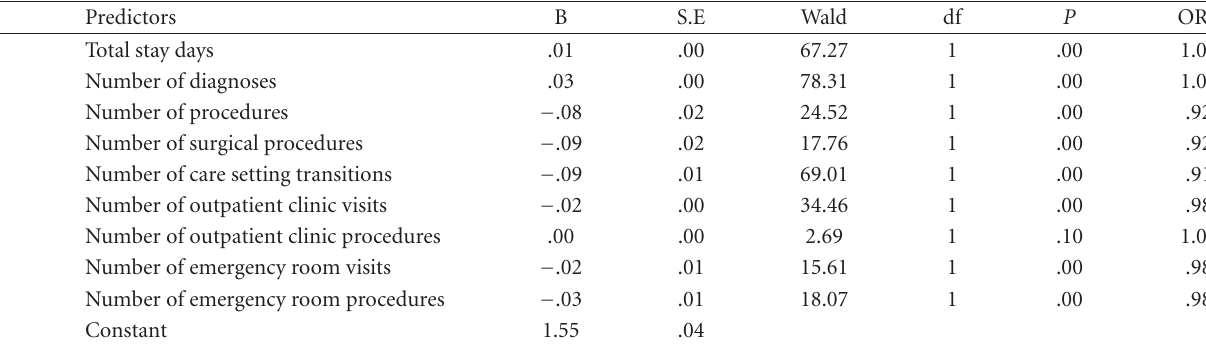
Table 2: Summary of logistic regression findings for younger and older subjects ( n = 10,897; reference category—older